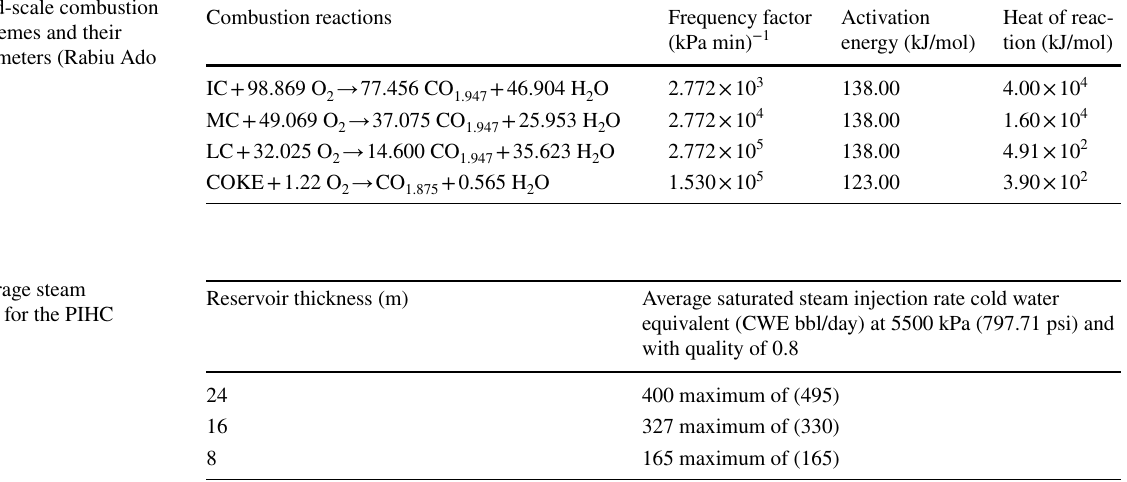
Table 4 Field-scale combustion reactions schemes and their kinetics parameters (Rabiu Ado